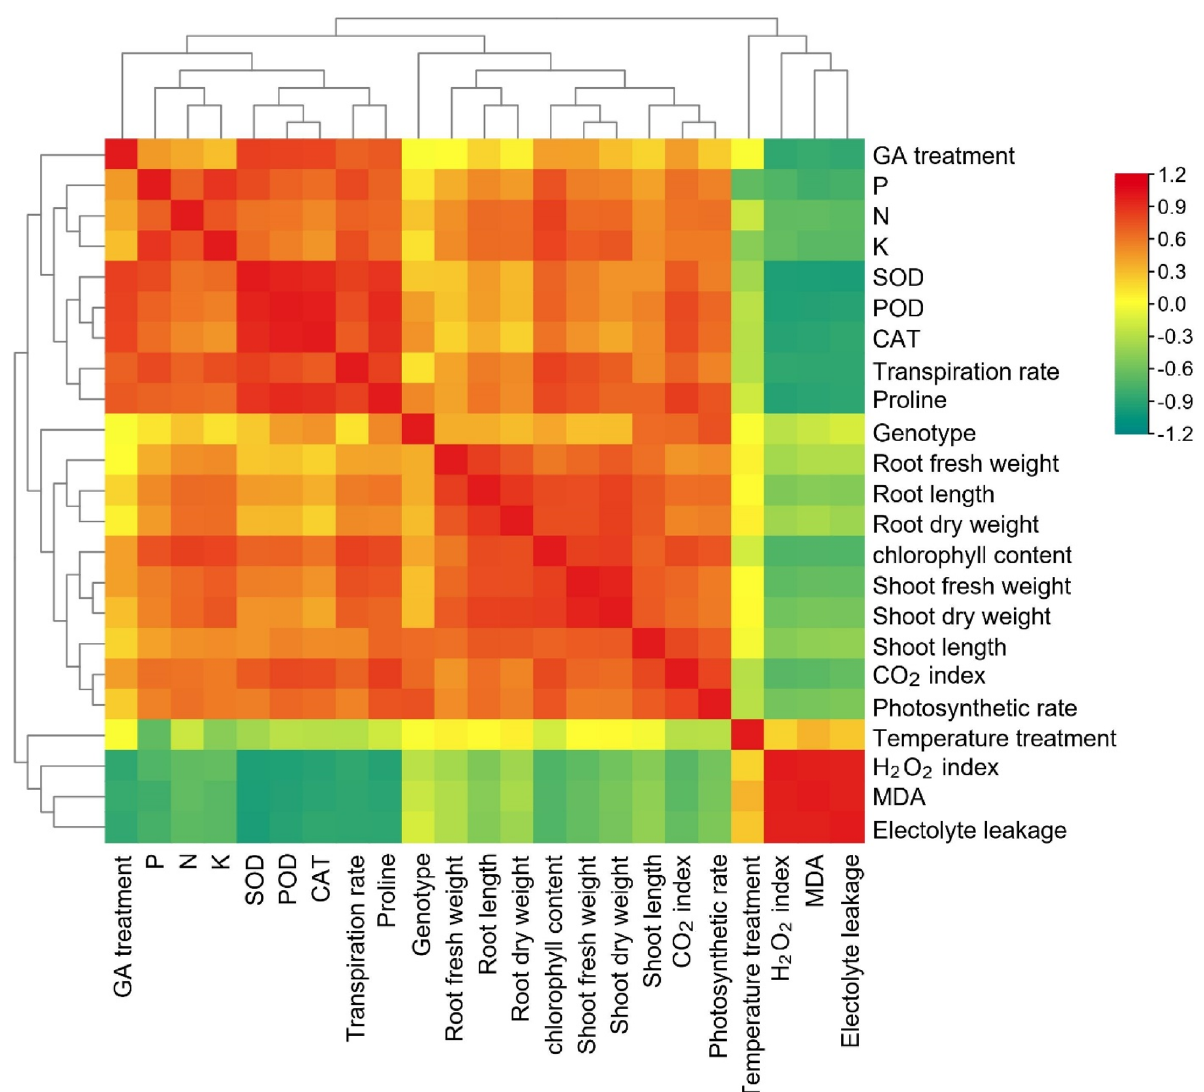
Figure 6. Correlation analysis among GA 3 treatments and various morphological, physiological, and biochemical variables of tomato cv. ‘Ahmar’ and ‘Roma’ under heat